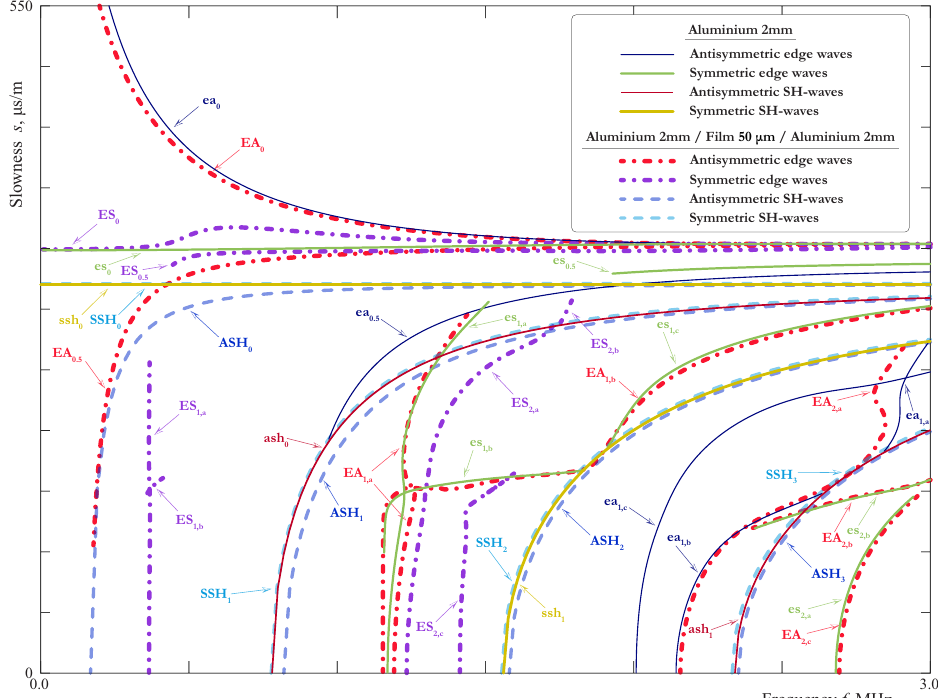
Figure 15. Slownesses of EWs and SH-waves propagating in 4.05 mm thickness symmetric lami- nate with a soft thin interlayer (2 mm aluminium/50 µ m film/2 mm aluminium) and 2 mm alu- minium